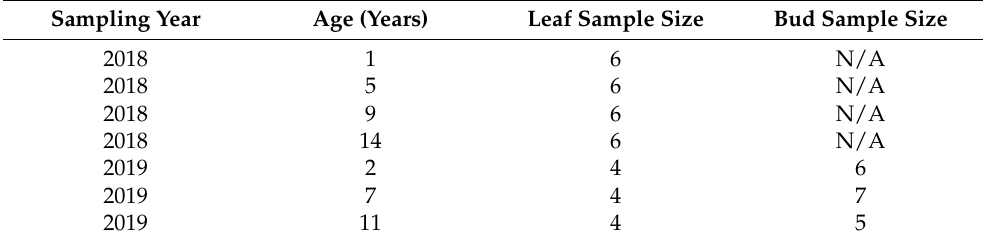
Table 1. Sampling scheme for 2018 and 2019 almond age cohort